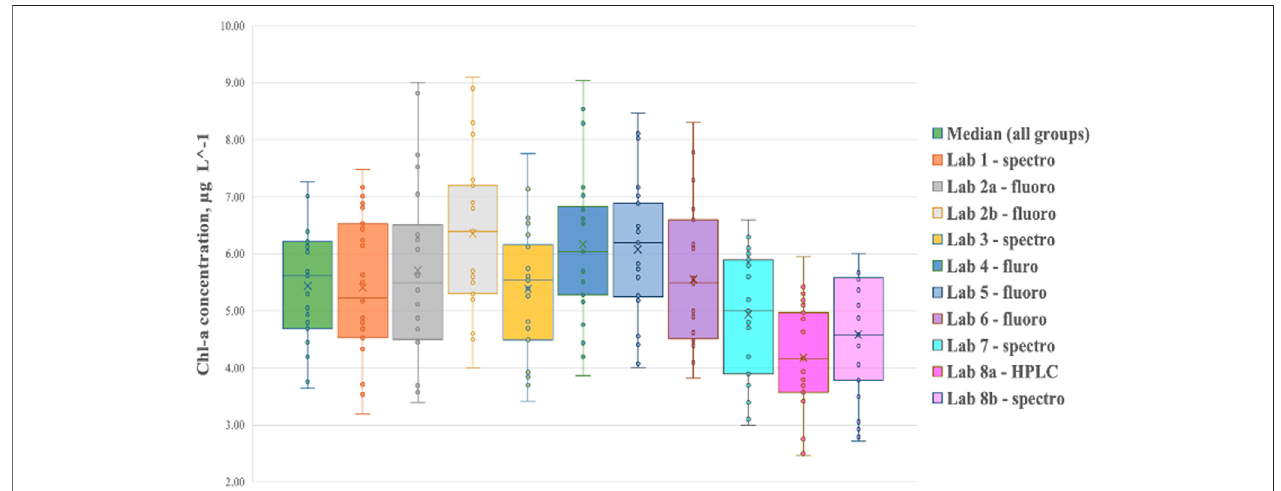
FIGURE2 | Boxplotsofthederivedchlorophyll-aconcentrationsmeasuredbyallparticipatinglabsintheBråvikencampaign.Eachlaboratorymeasuredthreereplicates from the surface taken at eight stations (i.e., 24 samples each per laboratory). Note that Lab 2 conducted fl ash-freezing (2a) and their normal sampling procedure (2b).